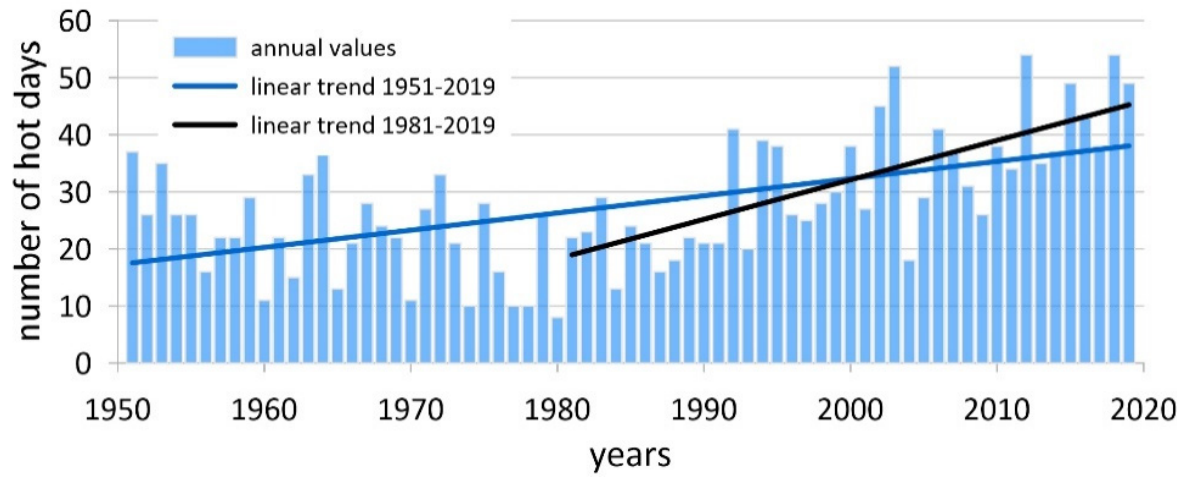
Figure 3. Annual frequencies of hot days in Poland in the period 1951–2019.